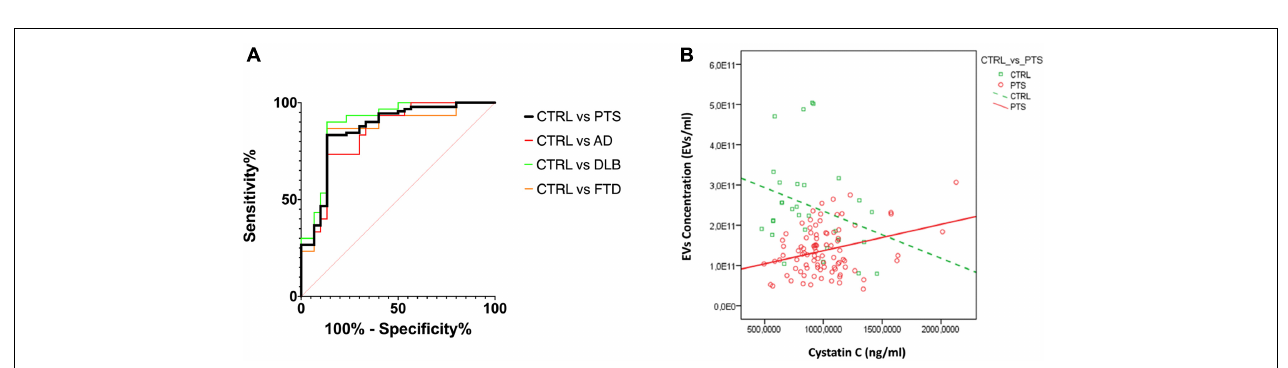
FIGURE 2 | Classification tree. Subjects are classified on the basis of the most predictive variables, EVs size and concentration, among all the ones which resulted to be significantly associated with subject groups. CTRL, controls; PTS, patients; AverageSize, EVs size; AverageConcentration, EVs/ml.